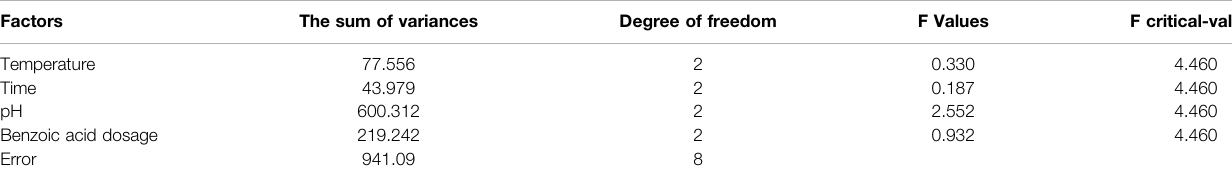
TABLE 3 | Variance results of orthogonal